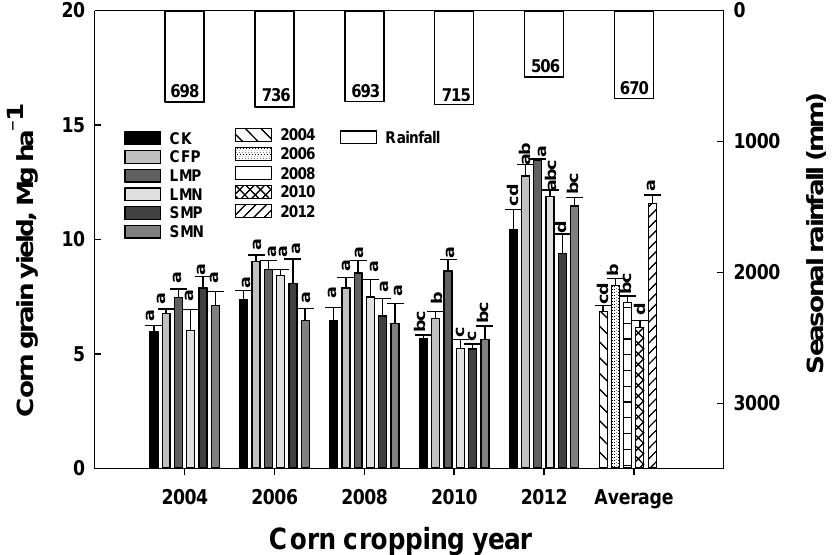
Figure 1. Effects of cropping year and the growing season rainfall on treatmentwise corn grain yield over 10-year (2004–2013) fertilization under corn-soybean rotation in a clay loam soil, Woodslee, ON, Canada. Error bar is the standard error of the mean ( n = 3). Different letters over the bars indicate the yields were significantly different at the p ≤ 0.05 level.